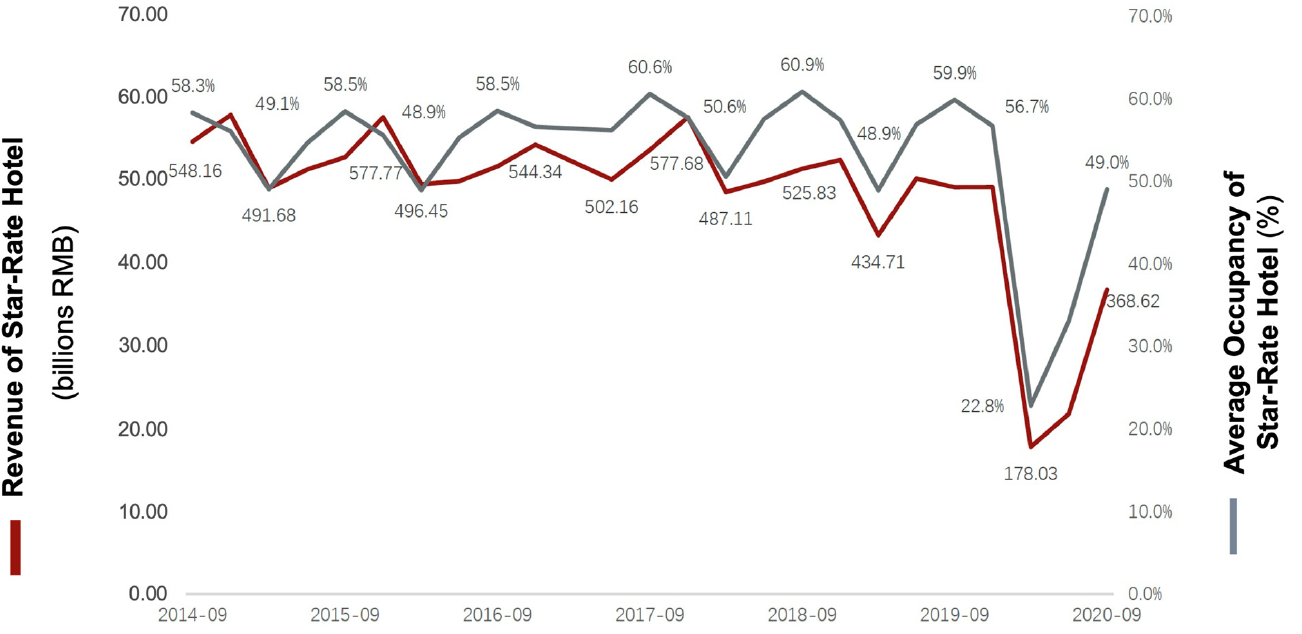
Table 3. The constraints of IoT application development in hospitality industry in China. Constraints